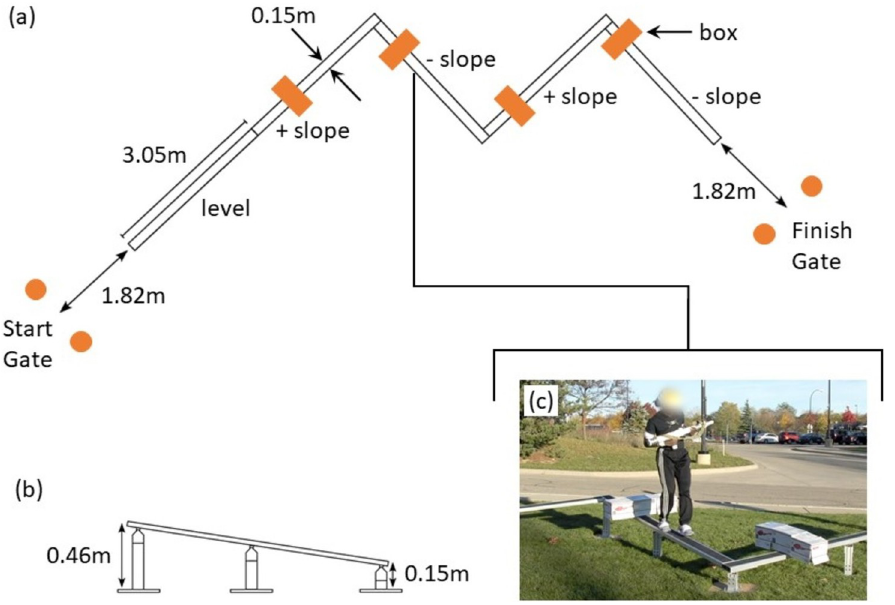
Fig 9. Balance beam obstacle. The layout for the balance beam obstacle in both (a) a top-down view and (b) a side view (b). (c) A photo of a participant completing the obstacle. The balance beam obstacle is composed of five elevated aluminum planks (0.15 m wide, 3.05 m long). The first plank is level, whereas the other planks alternately slope up or down by 9 degrees. The junction between the first and second planks is straight, whereas the other junctions are alternating right and left 90 degree turns. Four boxes (0.20 X 0.20 X 0.76 m) are placed on the beam to create an additional challenge for participants. The boxes are placed 1.04 m, 1.02 m, 0.71 m, and 0.30 m from the leading edge of the second, third, fourth and fifth planks,